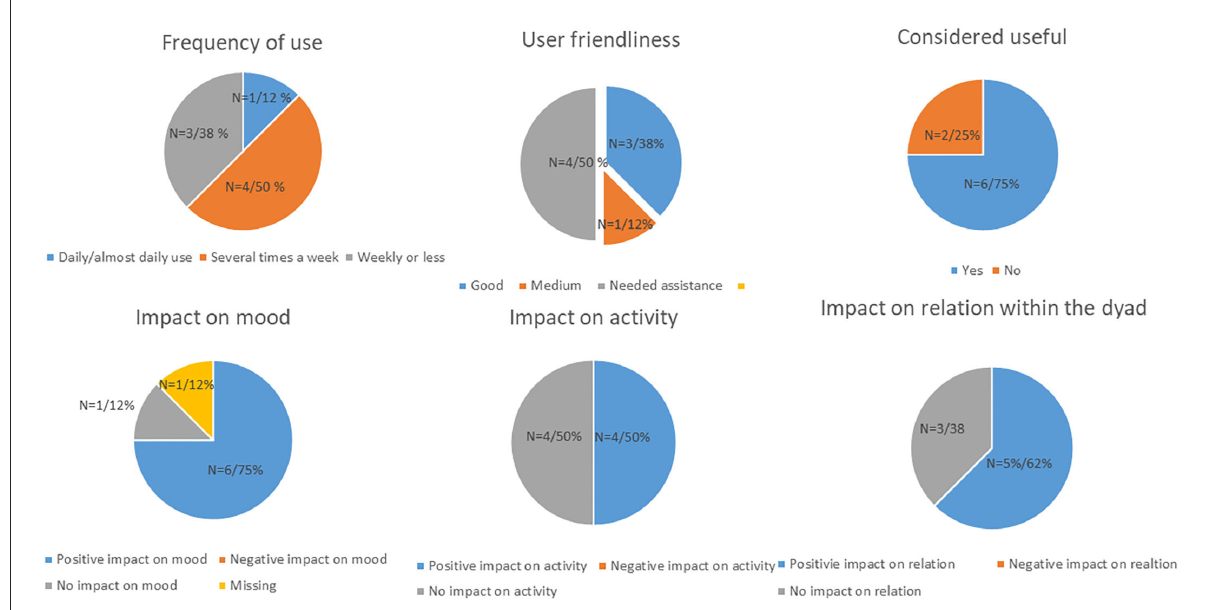
FIGURE4 Data on adoption and feasibility of the Alight application tested in 8 dyads of PwD and caregivers in the LIVE@Home.Path